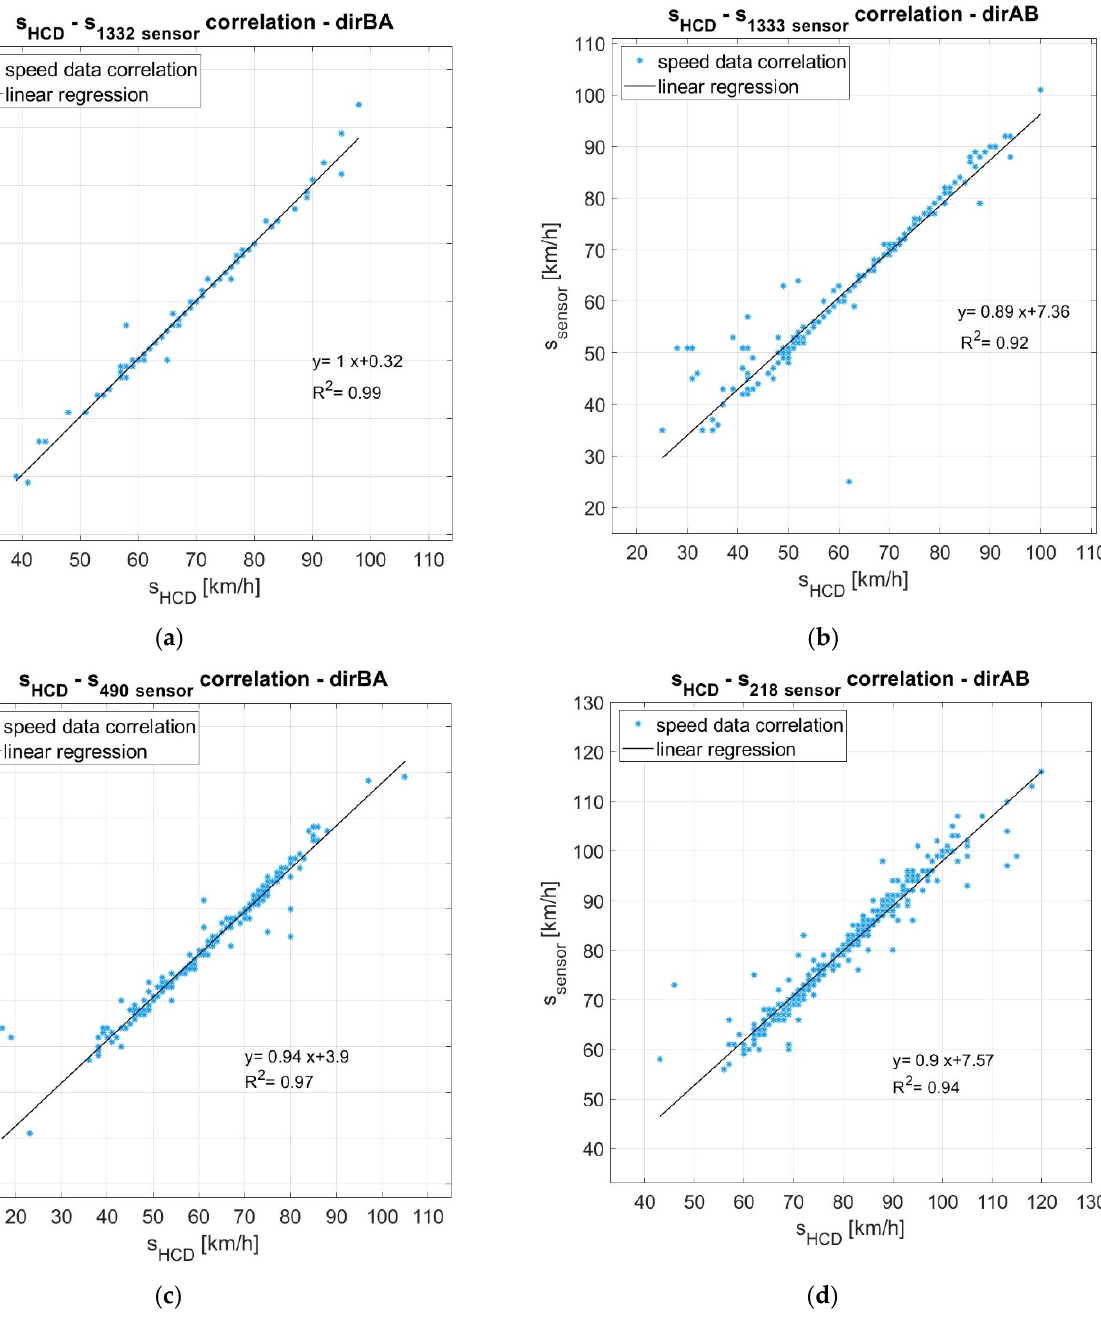
Figure 5. HCD and sensors’ speeds’ samples correlation: ( a ) Control unit 1332, BA direction; ( b ) Control unit 1333, AB direction; ( c ) Control unit 490, BA direction; ( d ) Control unit 218, BA direction.